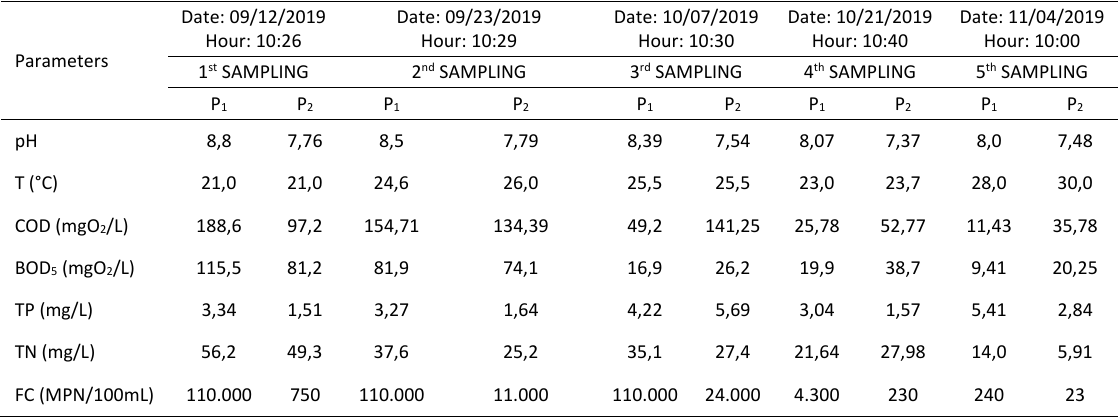
Constructed wetland performance for each parameter